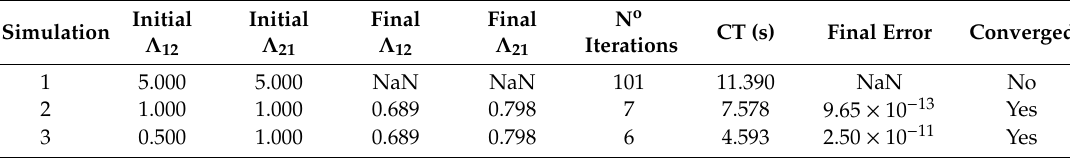
Table 4. Results for simulation by using Newton’s method.